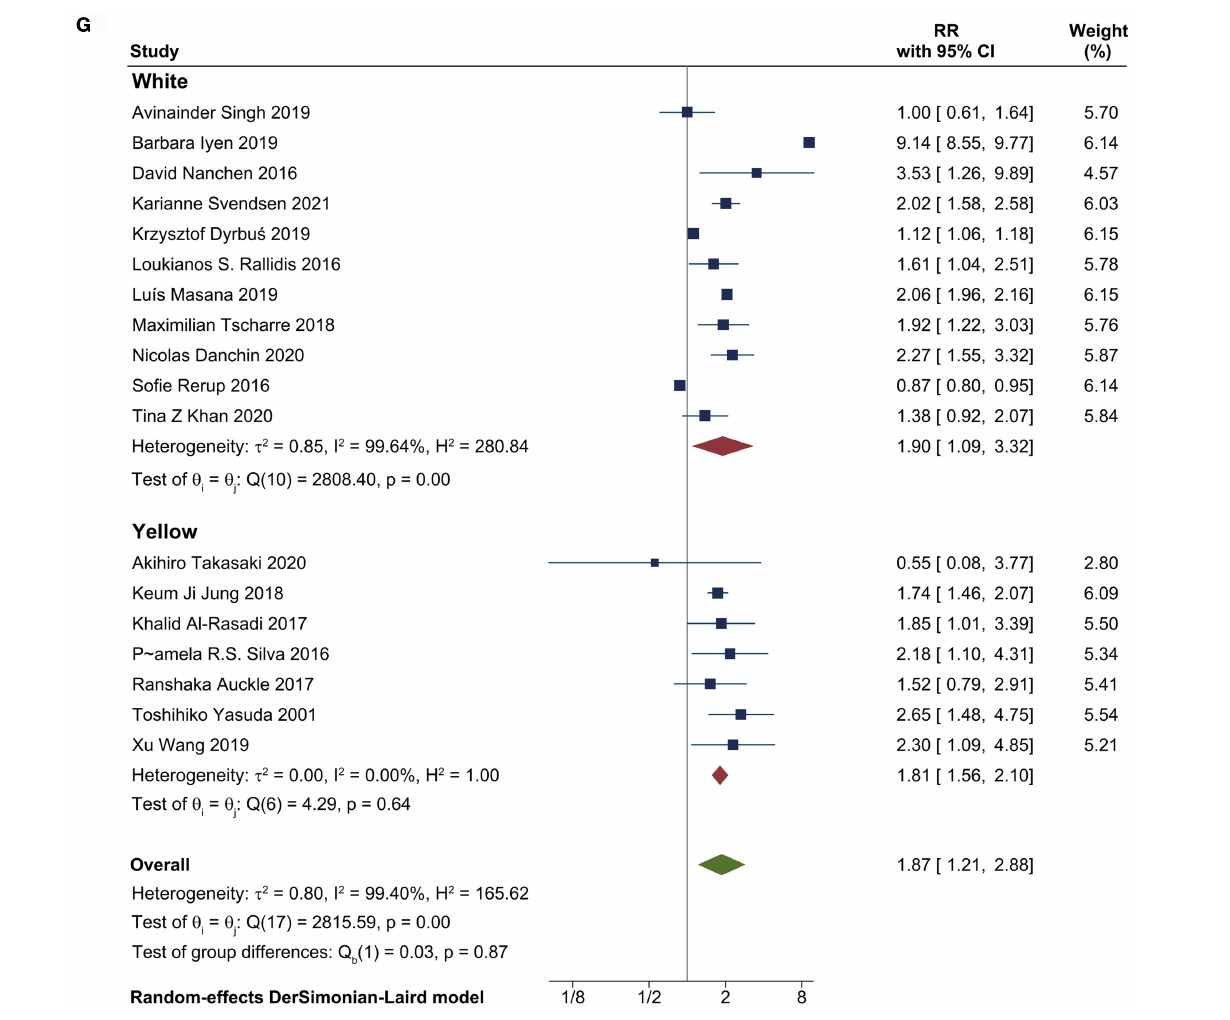
(95% CI 1.24–1.72), 1.71 (95% CI 1.19–2.46) and 1.75